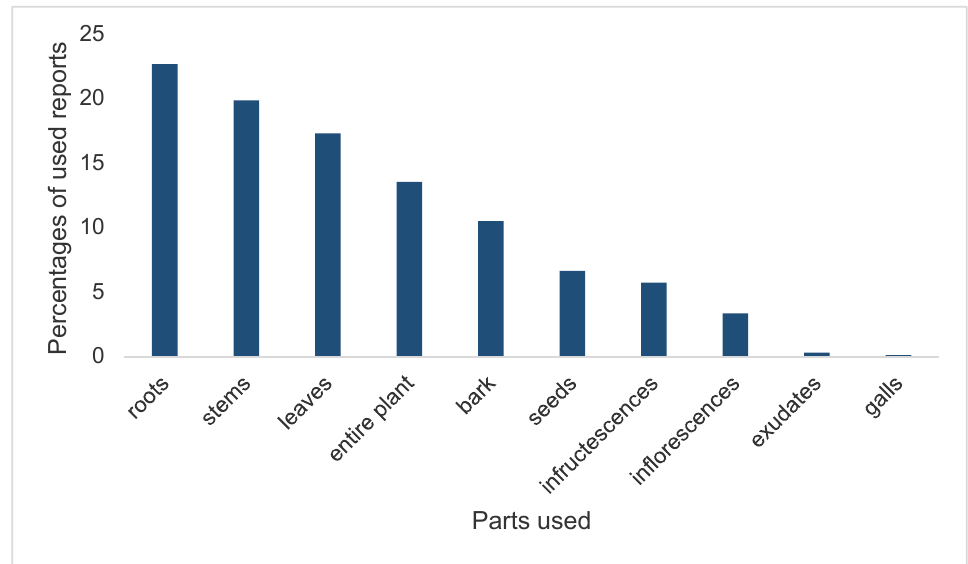
Figure 3 . Proportion of use reports for each plant part of legume species in Thailand with medicinal uses, from 152 primary data sources produced from 1986–2019.